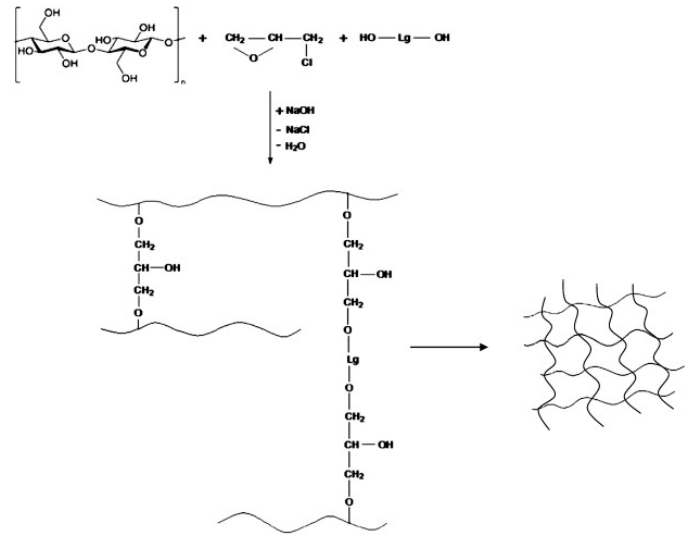
Figure 6. Schematic representation of the preparation of cellulose/lignin hydrogels crosslinked with epychlorhydrin. Reproduced with the permission from Ciolacu et al. [46]. Copyright © (2012) Elsevier.